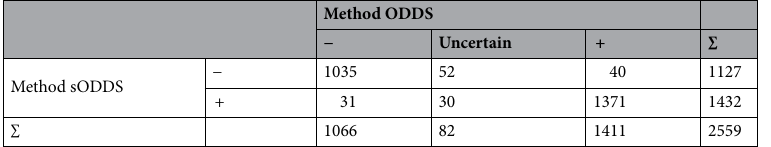
Table 3. Receptor status according to ODDS. 2559 Patients have been assessed for hormone receptor status by sODDS to comprise the input dataset. A sample was considered H + if at least one receptor was positive. Difference in methods is reflected in Cohen’s κ = 0.88.